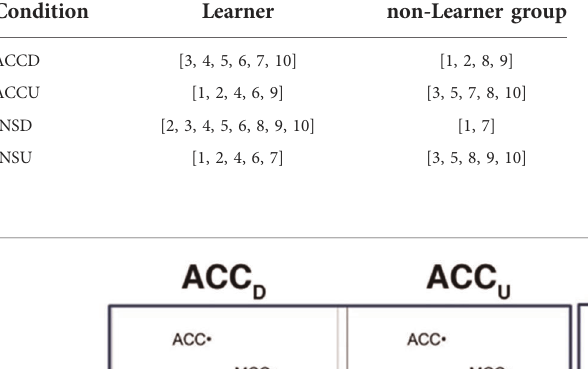
TABLE 3 Classi fi cation of participants in the learner or non-learner groups for each condition (ACCD, ACCU, INSD, INSU). Condition